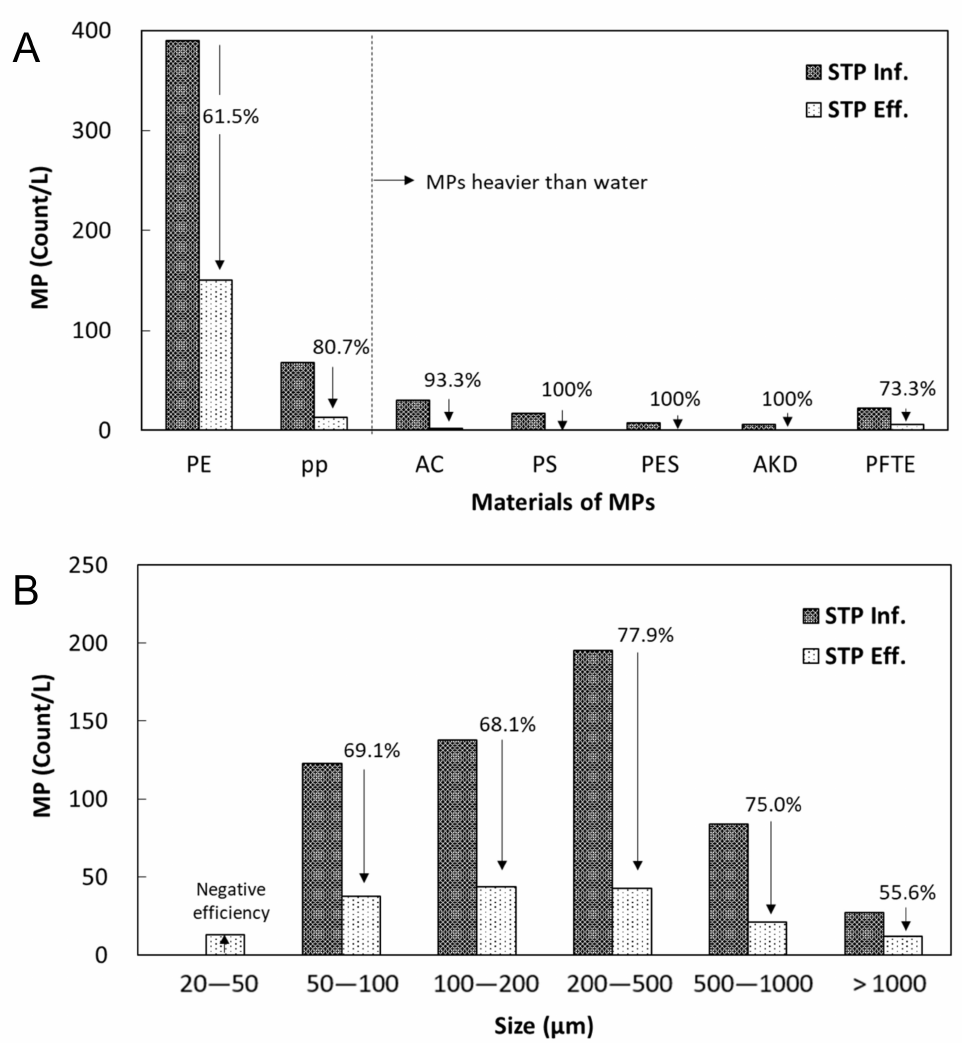
Figure 3. Number distributions of MP particles in the influent and effluent of the conventional anaerobic–anoxic–aerobic (A 2 O) system for ( A ) different materials and ( B ) different size ranges. PE: Polyethylene, PP: Polypropylene, AC: Acrylate, PS: Polystyrene, PES: Polyester, AKD: Alkyd, PTFE: